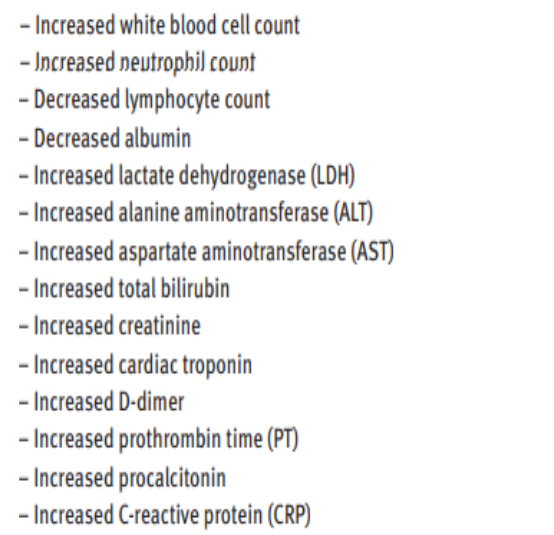
Figure 1. Main abnormalities noted by [12] in COVID-19